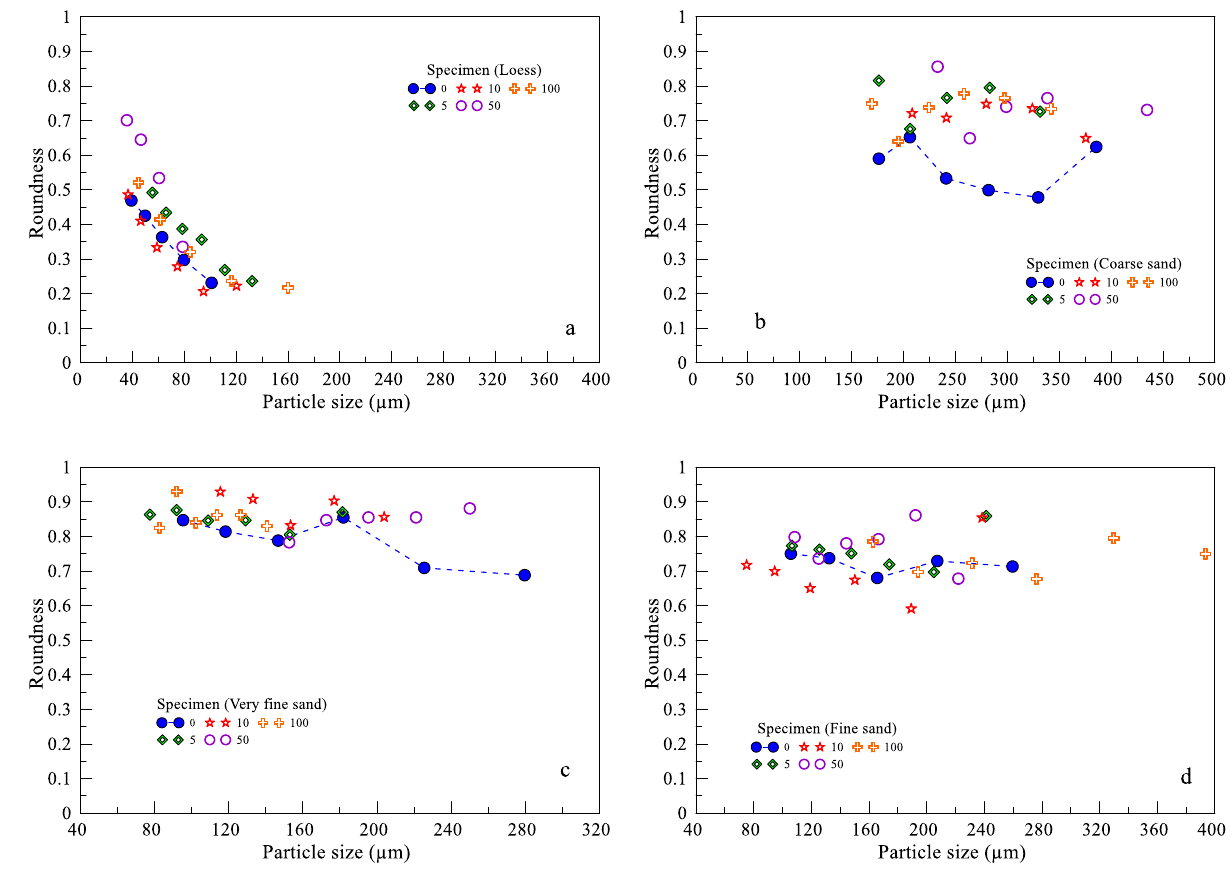
Figure 8. Changes in particle size and roundness of each type of soil after freeze–thaw cycles. ( a Specimen (L); b Specimen (CS); c Specimen (VFS); d Specimen